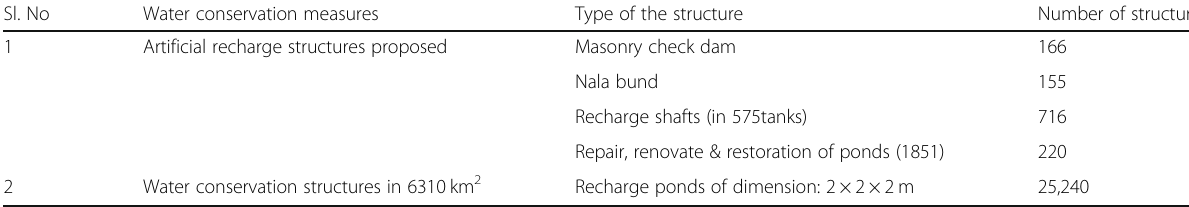
Table 3 Proposed types and number of artificial recharge structures to be constructed Sl.